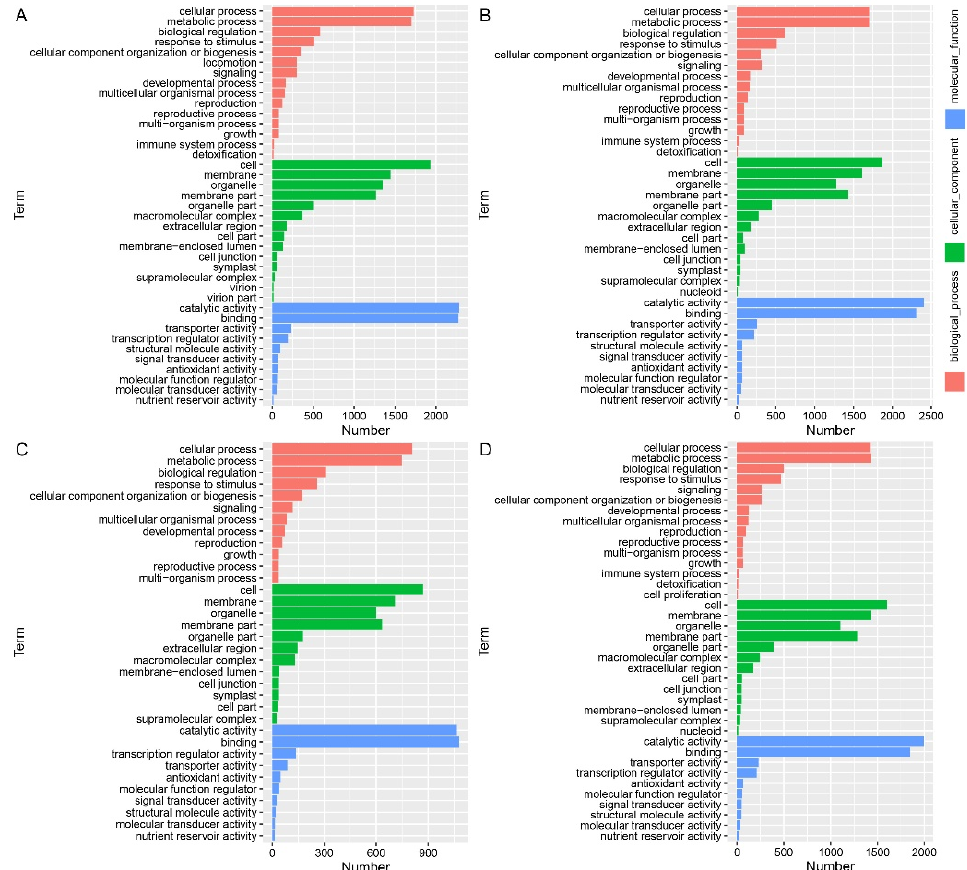
Figure 6. GO annotations of DEGs in B73 and lpa1 identified under different treatments. ( A ) B73- CK vs. B73-100; ( B ) B73-CK vs. B73-500; ( C ) lpa1-CK vs. lpa1-100; ( D ) lpa1-CK vs. lpa1-500. CK = control, 100 = 100 μ mol·L − 1 IAA, and 500 = 500 μ mol·L − 1 IAA.